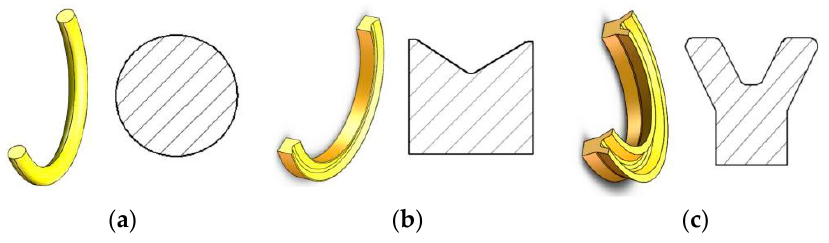
Figure 3. Schematic diagram of elastic sealing ring: ( a ) O-ring seal; ( b ) V-ring seal; ( c ) Y-ring seal. According to the structure and shape of the elastic parts, they can be divided into O-ring seals [15], V-ring seals [16], and Y-ring seals [17]. Many scholars continue to improve